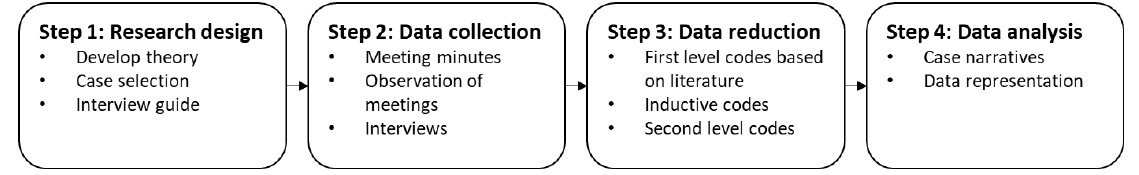
Figure 1. Case study